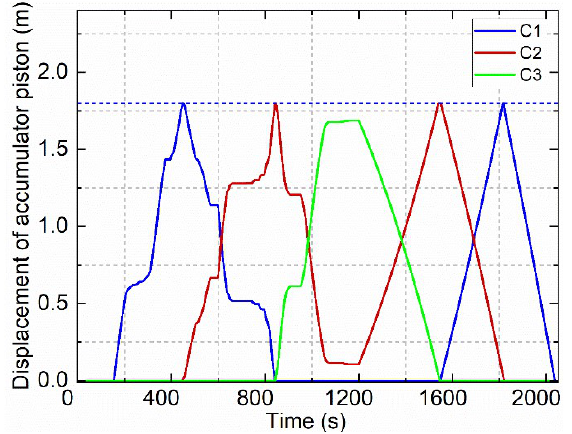
Figure 6. Piston displacement of accumulators.